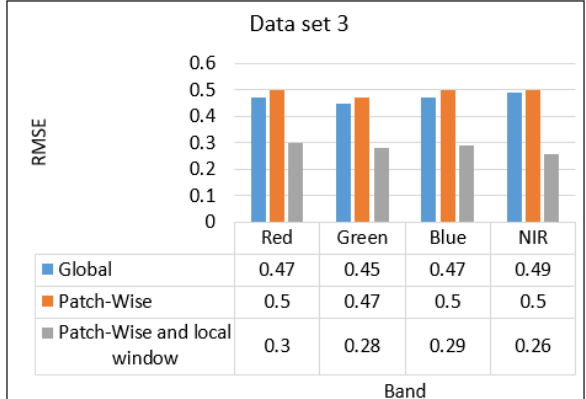
Figure 16. Final accuracy of band to band registration of the 4 bands with the reference of the red-edge band, data set 3 For Patch-Wise and local window based methods, the selection of window size is one of the important challenges. Figure 17 shows the number of extracted points for different window sizes. As the window size increases, the number of extracted points also increases, but duplicate points may be extracted, which itself increases the processing time. The larger the size of the window, the lower the correct matching rate, and the speed of the run with a sharp drop. Therefore, the window with small dimensions has more precision in matching (Zhao, et al, 2018).